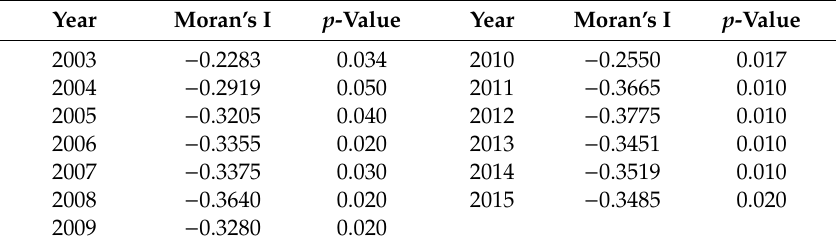
Table 3. Land use eco-efficiency Moran’s I index in China from 2003 to 2015.